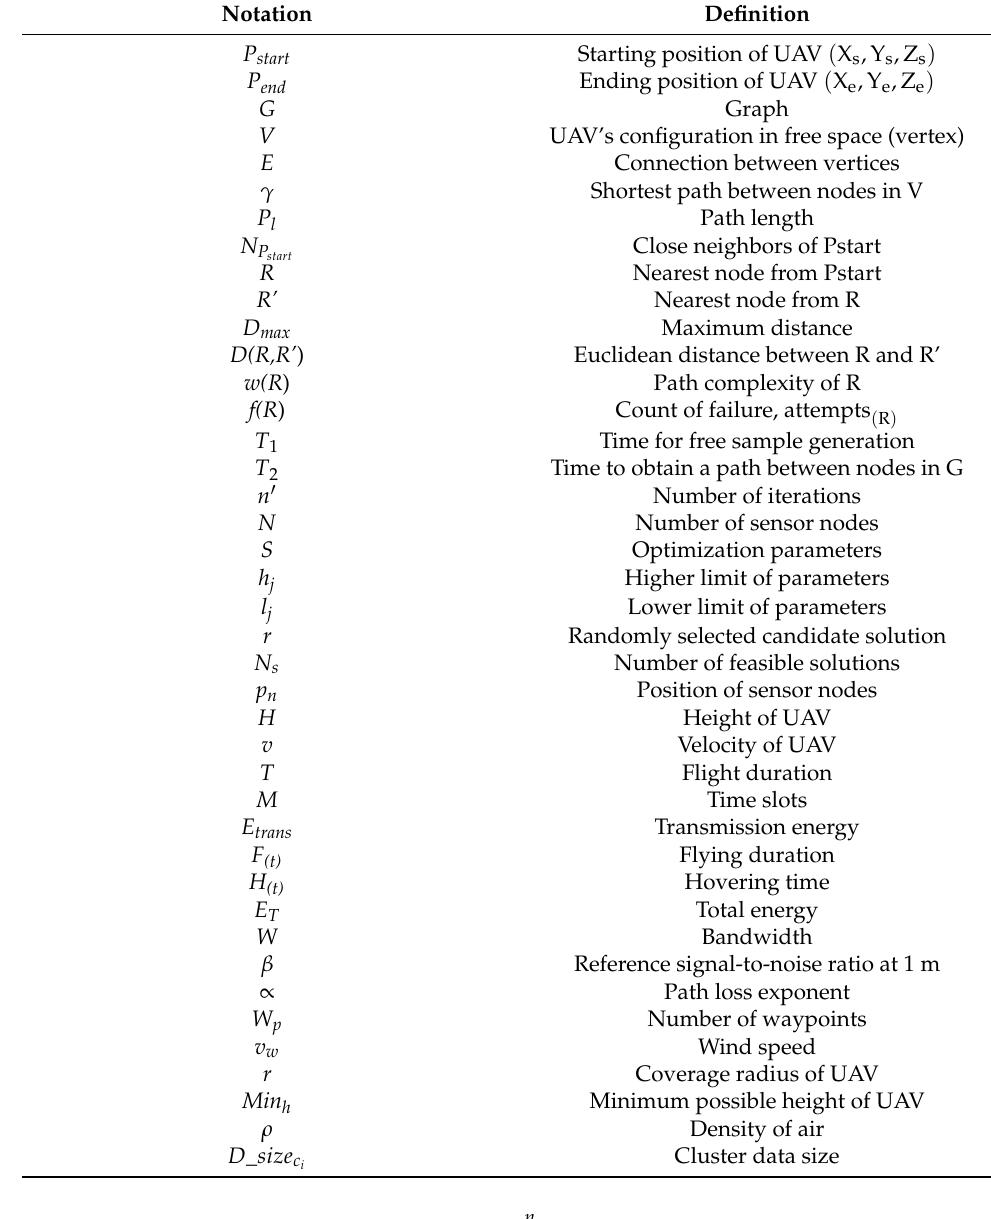
Table 2. List of